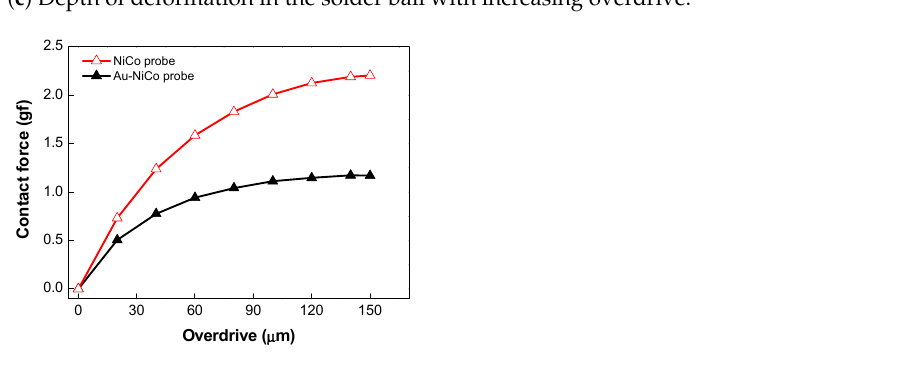
Figure 9. Variation in contact forces with increasing overdrive when the probe contacted the Cu pillar microbump.